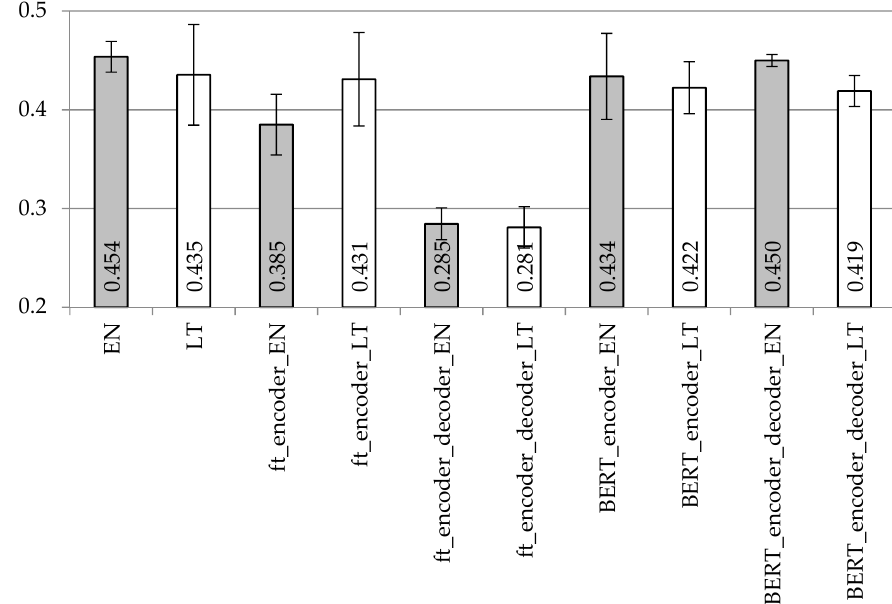
Figure 6. Averaged BLUE scores with confidence intervals using the LSTM encoder and decoder model with different vectorization types on the dataset with separated punctuation.